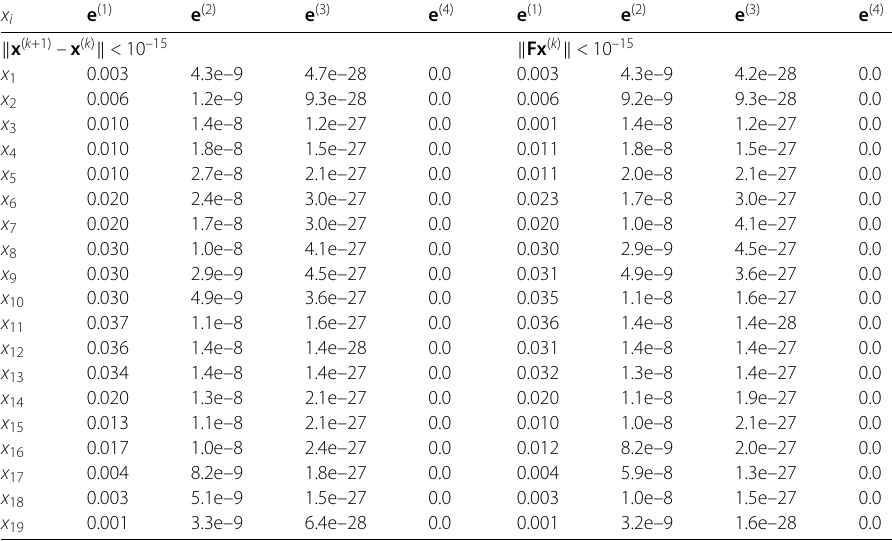
Table 8 Residual errors of different iterations of QQ1 for solving F 7 ( X ) x